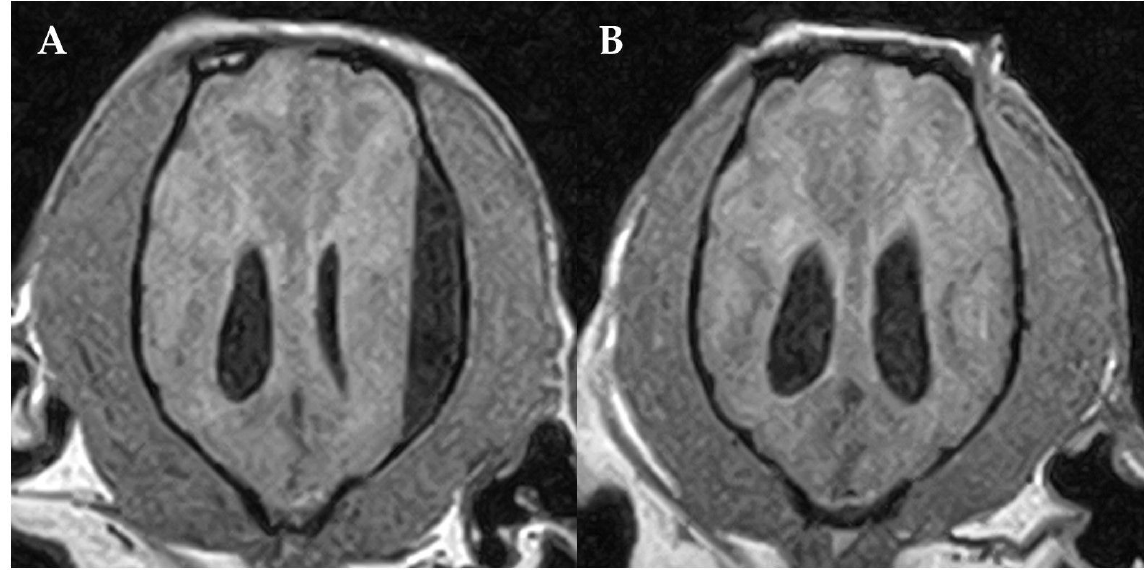
Figure 3. Pre- ( A ) and post-surgical ( B ) MRI of the dog´s brain. Dorsal 3DT1W ( A , B ). Post-surgical MRI ( B ) confirmed the resolution of the SFA. The left side of the patient is on the right side of the image. The dog remained stable for two weeks after surgery, then started to have generalized epileptic seizures that were treated with phenobarbital 3 mg/kg PO twice daily (Phenoleptil ® , Dechra, Oudewater, The Netherlands), and finally developed cognitive decline and non- ambulatory tetraparesis and was therefore euthanized four weeks after